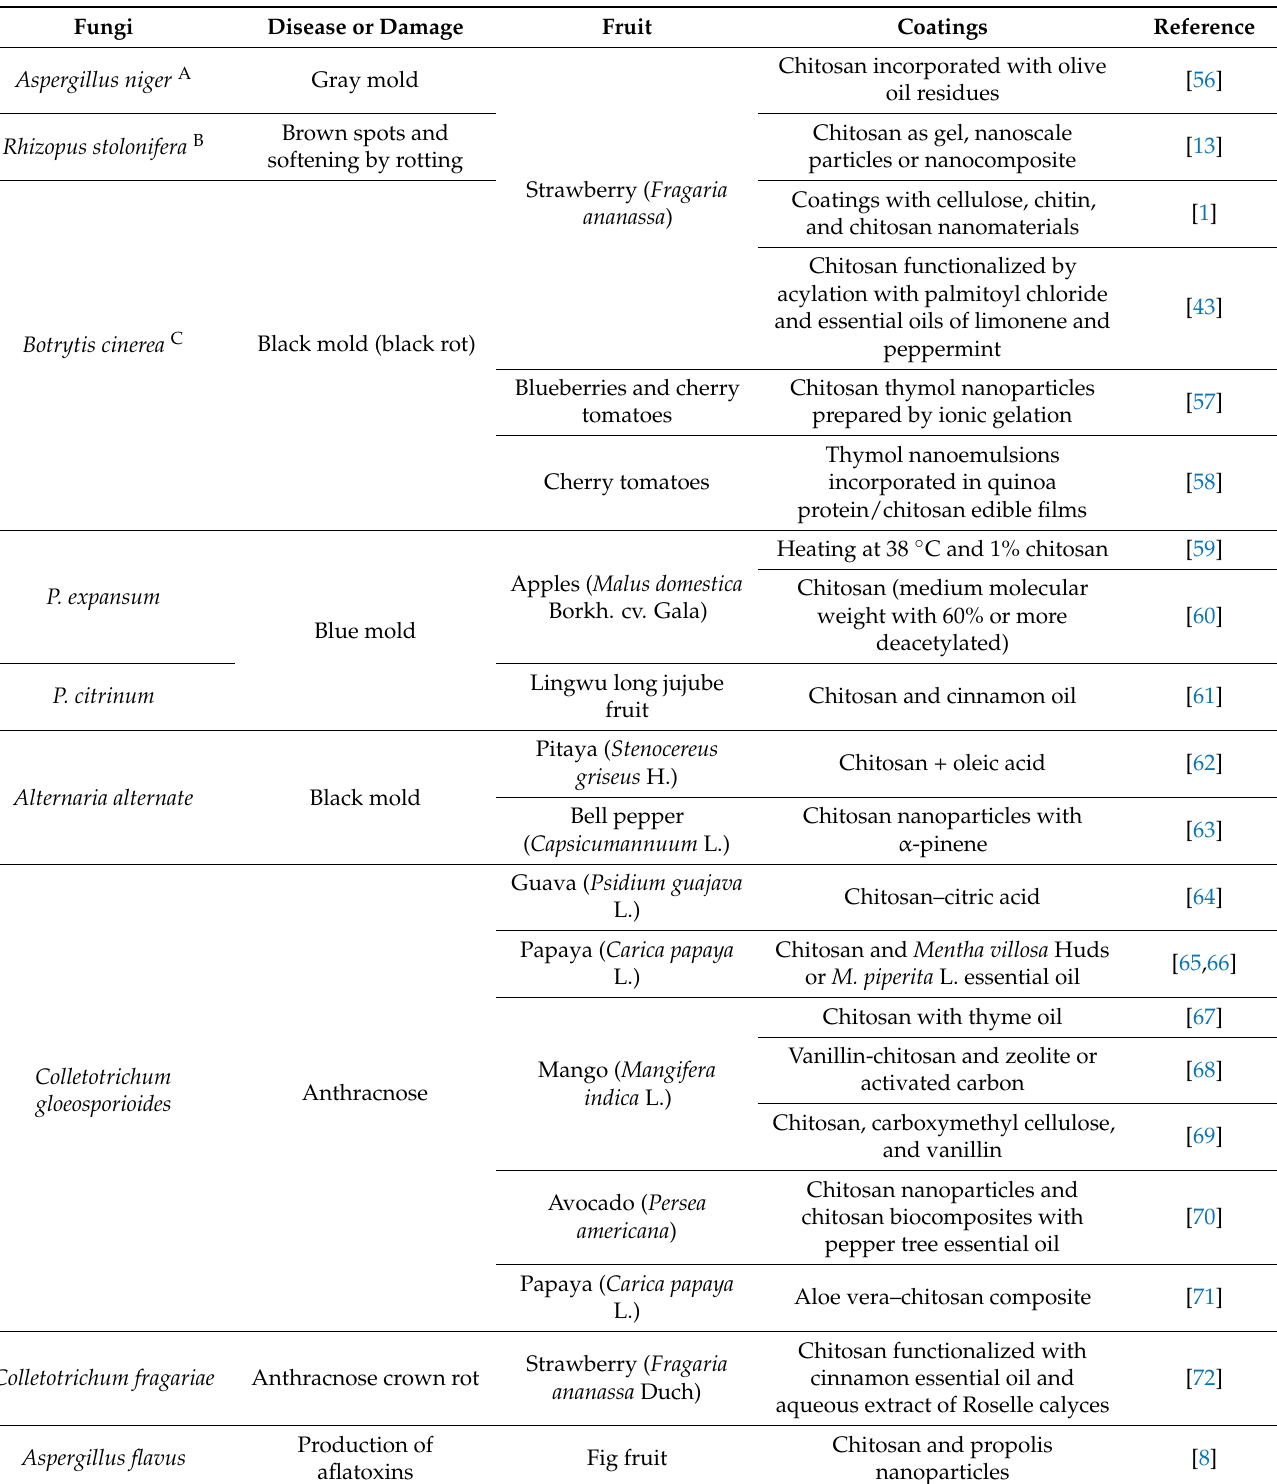
Table 2. Fungi that affect postharvest fruit quality: analysis from 2011 to